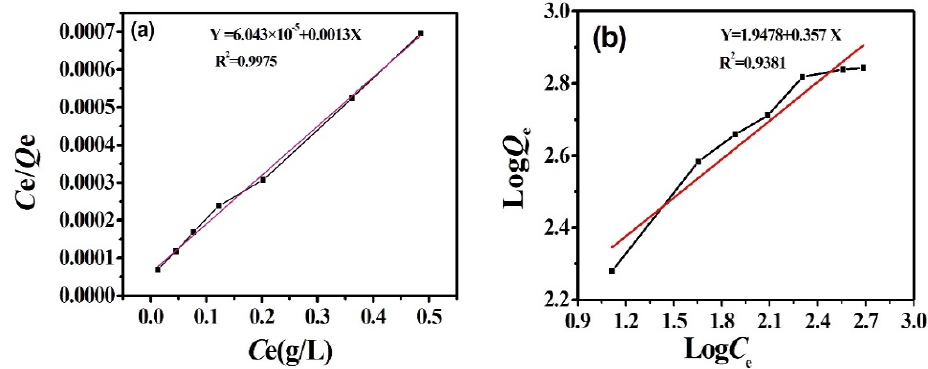
Figure 11. The Langmuir and Freundlich adsorption isotherm curves of lysozyme on aerogel.